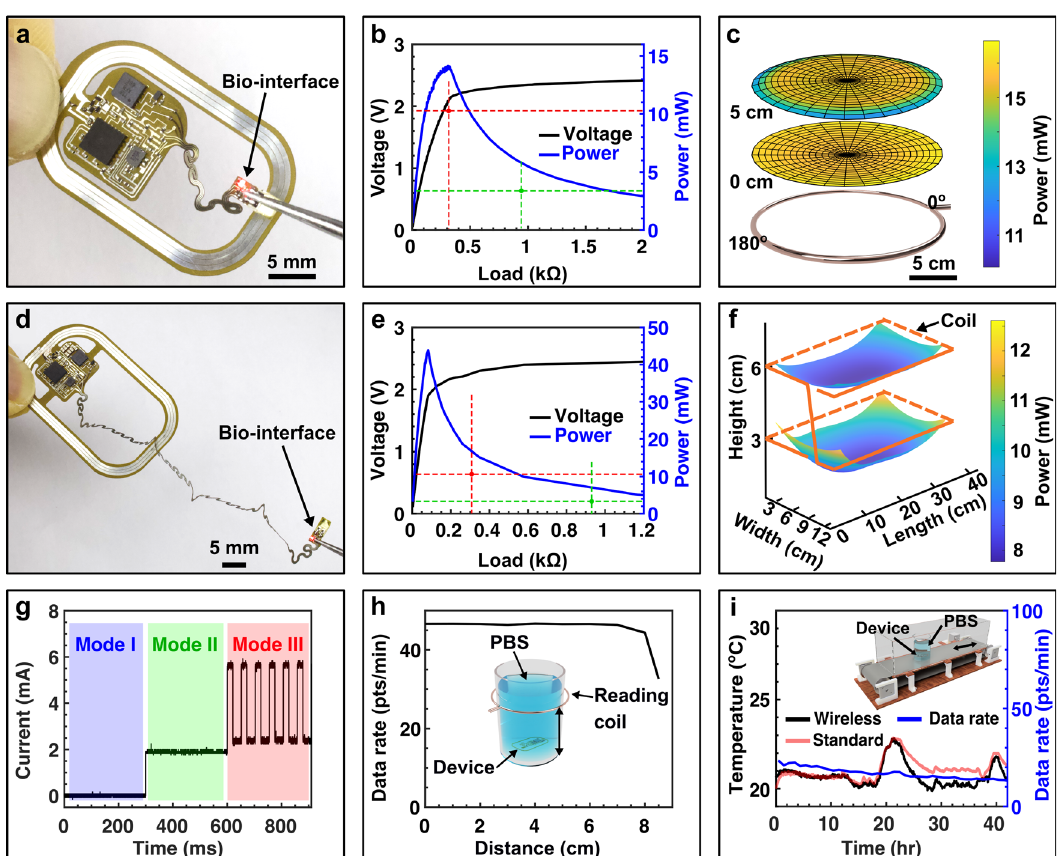
Fig. 2 System characteristics of osseosurface electronic systems. a – c Device for large animal models. Device photograph ( a ). Harvested power and voltage as functions of electrical load ( b ). Spatial distribution of harvested power using a handheld primary antenna at a load of 300 Ω ( c ). d – f Device for small animal models. Device photograph ( d ). Harvested power and voltage as functions of electrical load ( e ). Spatial distribution of harvested power using a 45 cm × 12 cm primary antenna measured with a load of ~900 Ω ( f ). g Power consumption of the device operating at different modes: I.